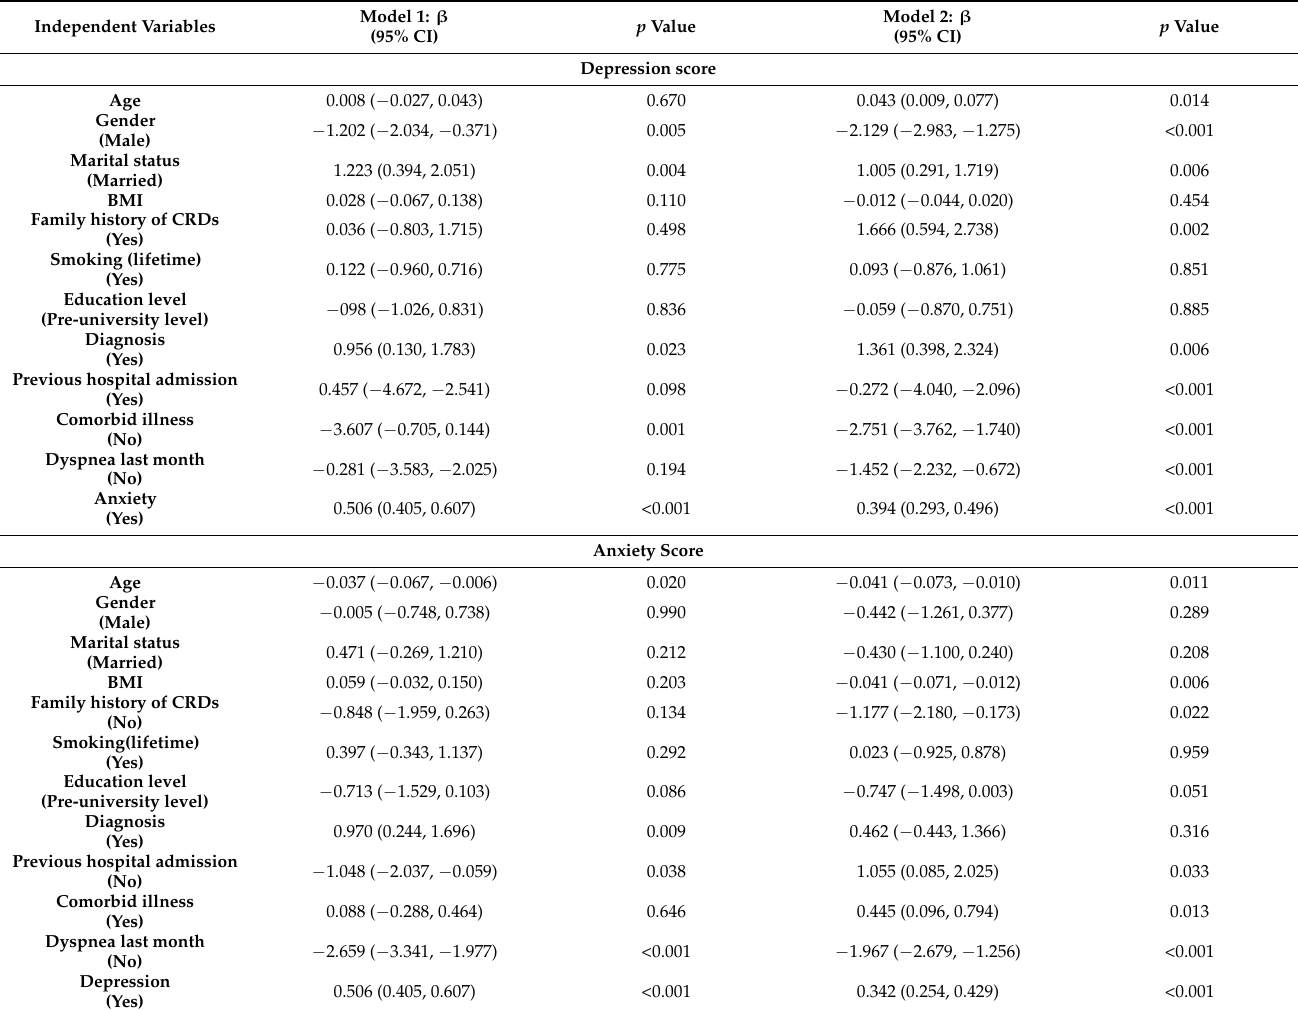
Table 5. Regression analysis of depression and anxiety scores based on the characteristics of patients with chronic respiratory diseases (N =